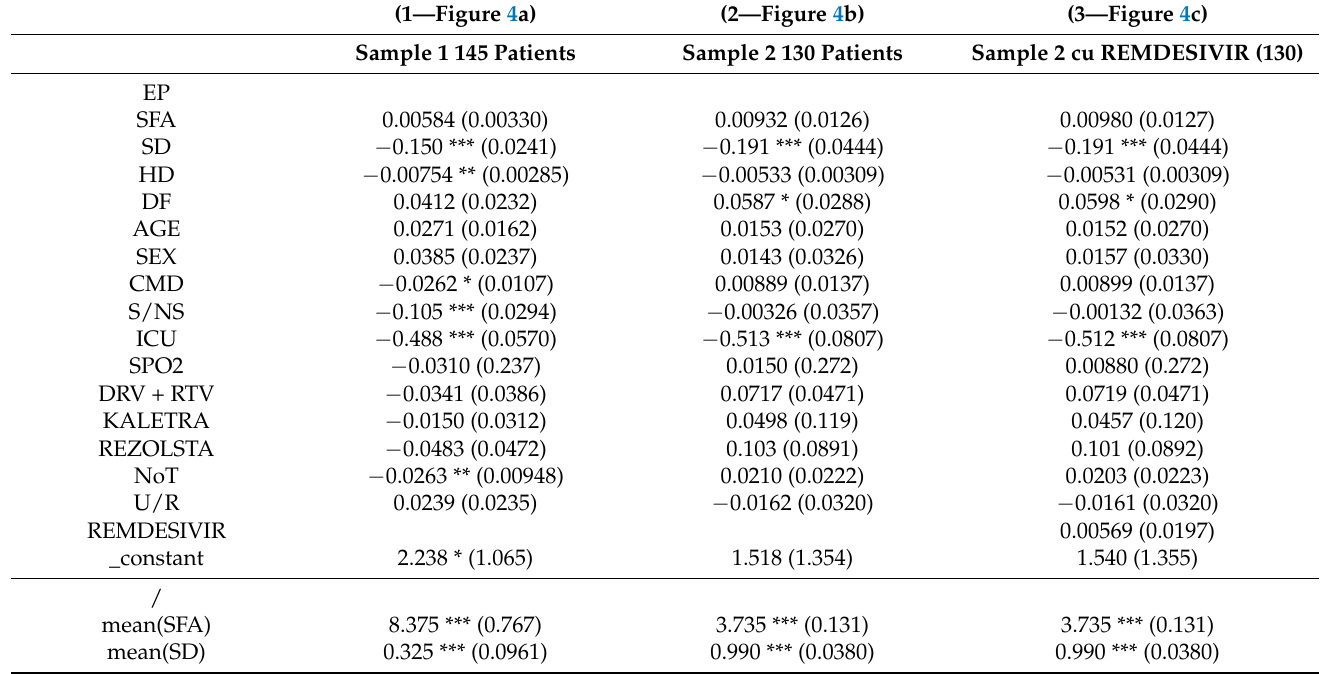
Table A2. Detailed SEM results associated with Figure